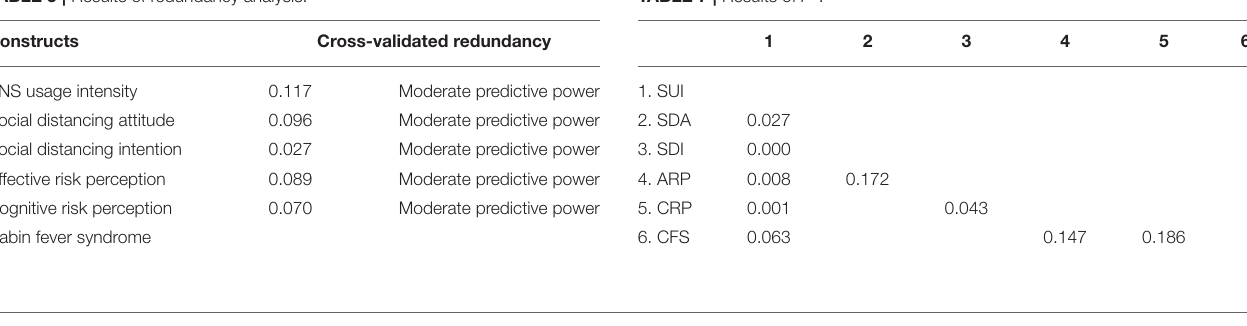
TABLE 6 | Results of hypothesis